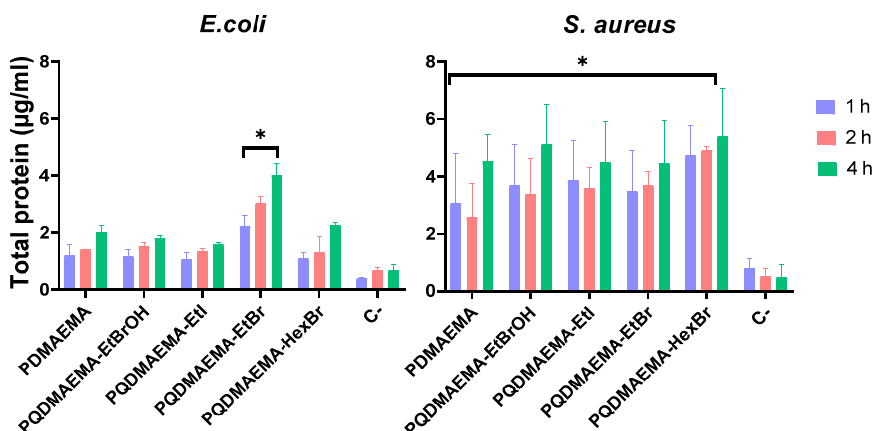
Figure 5. Protein leakage determined by the Bradford assay for E. coli and S. aureus incubated in the presence of the polymers at a concentration of 5 mg/mL, or in the absence of the polymers (negative control, C − ) for 1, 2 or 4 h. The asterisk (*) designates significant differences in the presence of the different polymers compared to the E. coli and S. aureus control at each experimental time point ( p < 0.001).